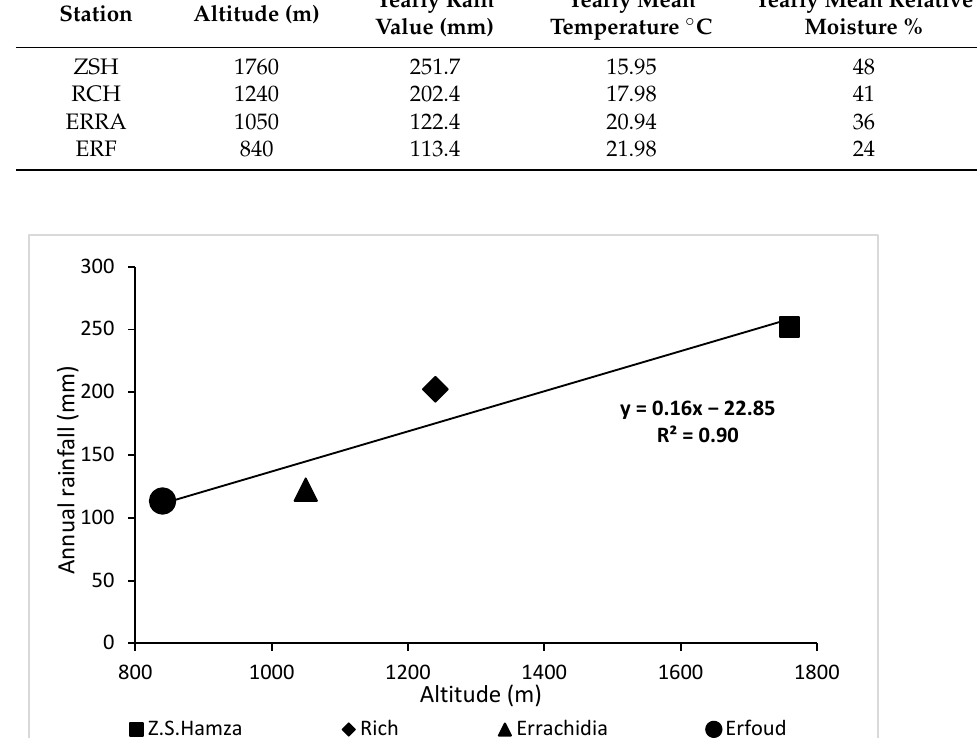
Figure 8. Correlation of rain vs. altitude. Table 2. Mean climatic parameters for the period December 2019–November 2020 of the four cli- matic stations. (Zaouïa Sidi Hamza (ZSH), Rich (RCH), Errachidia (ERRA), and Erfoud (ERF)).